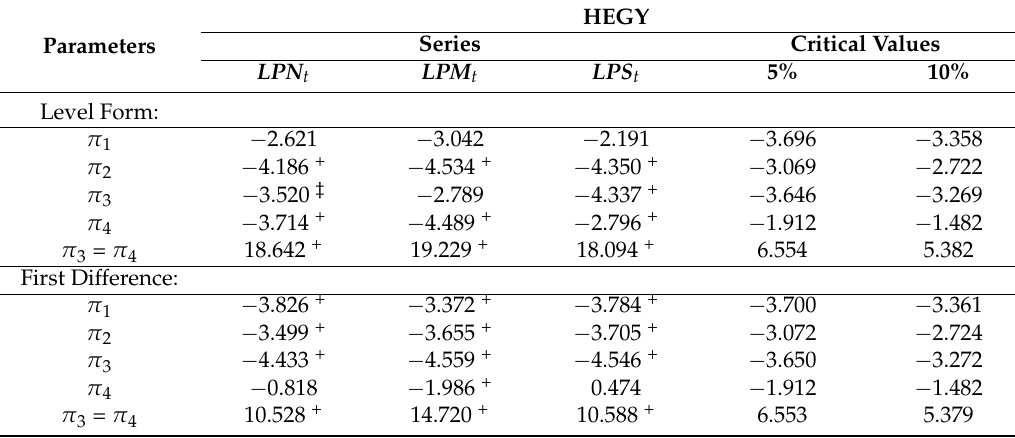
Table 5. Seasonal time series unit root tests.